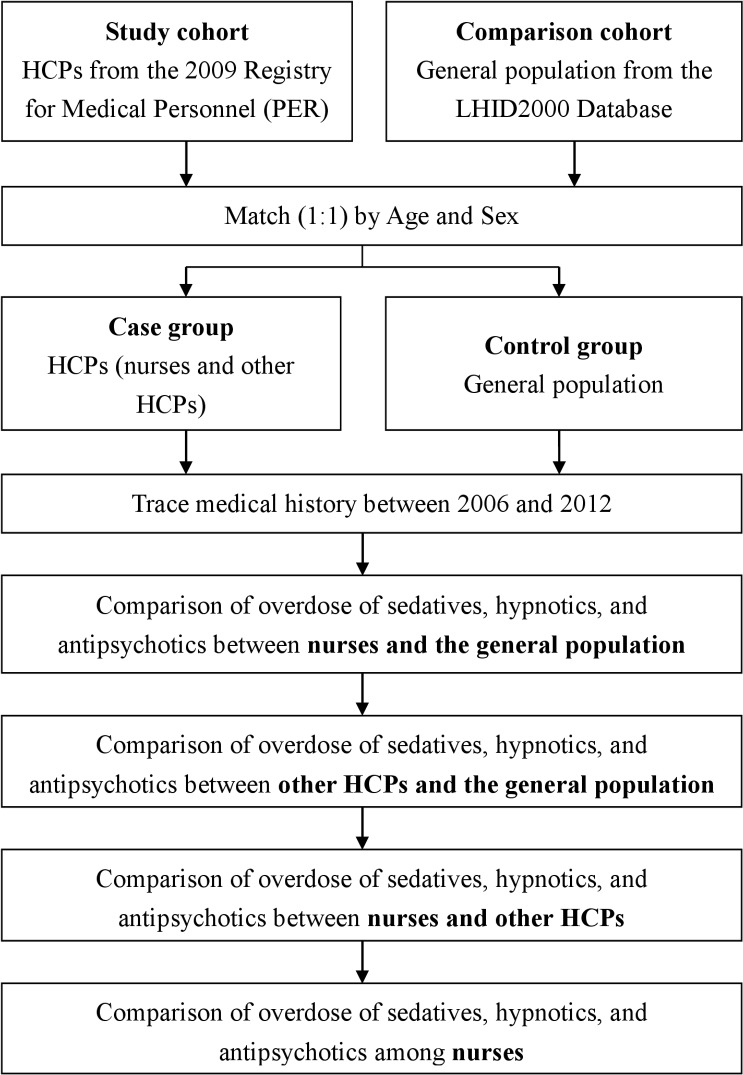
Flowchart of the study.HCP, healthcare provider; LHID, Longitudinal Health Insurance Database.